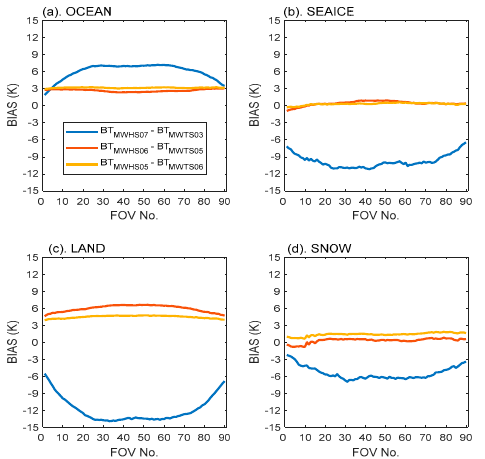
Figure 4. Angular dependence for the difference between three paired channels with 90 FOVs over ( a ) ocean; ( b ) sea ice; ( c ) land and ( d ) snow. The blue, red and yellow curves in figures ( a – d ) represent results for CESI low , CESI mid and CESI high , respectively.